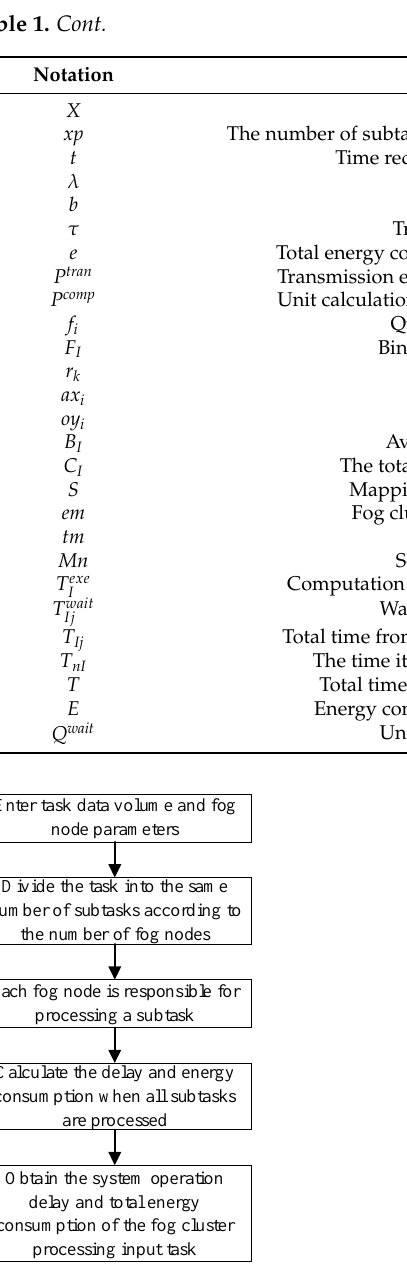
Figure 2. Load-balancing process.